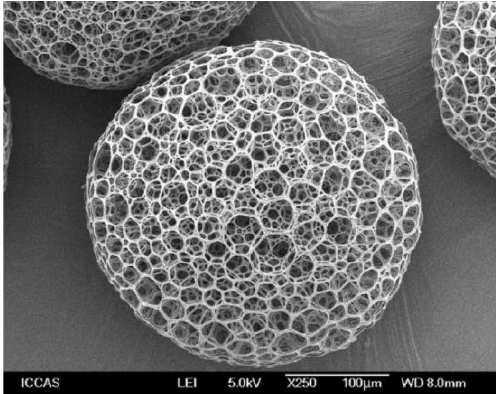
Figure 4. Poly( D , L -lactide) (PDLLA) porous microparticles fabricated with the aid of ammonium bicarbonate and further hydrolyzed with NaOH to increase the porosity and pore-interconnectivity. Reprinted from [60] with permission from Wiley Online Library, 2009.